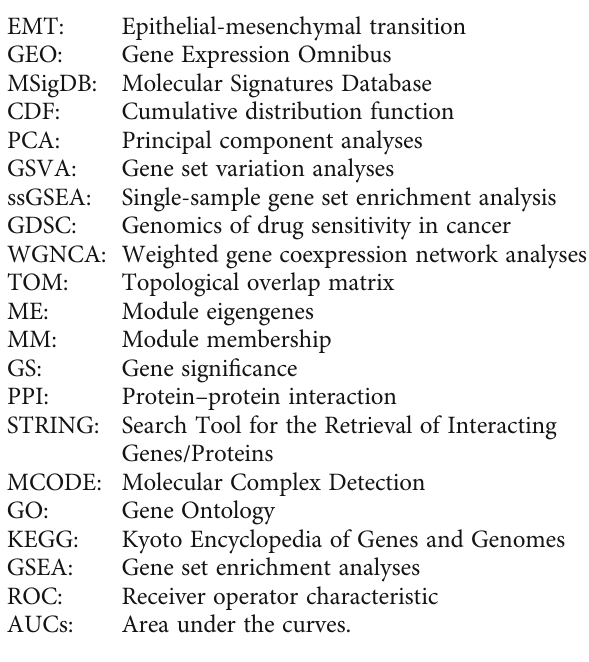
Supplementary 1 . Supplementary Figure 1: the di ff erences in immune cell in fi ltrations between two EMT subtypes using TIMER2 approach. Supplementary 2 . Supplementary Table 1: the information of EMT genes from the Molecular Signatures Database. Supplementary 3 . Supplementary Table 2: the gene set of each step within the cancer immunity cycle. Supplementary 4 . Supplementary Table 3: comparison of the activity of hallmark pathways in two EMT molecular